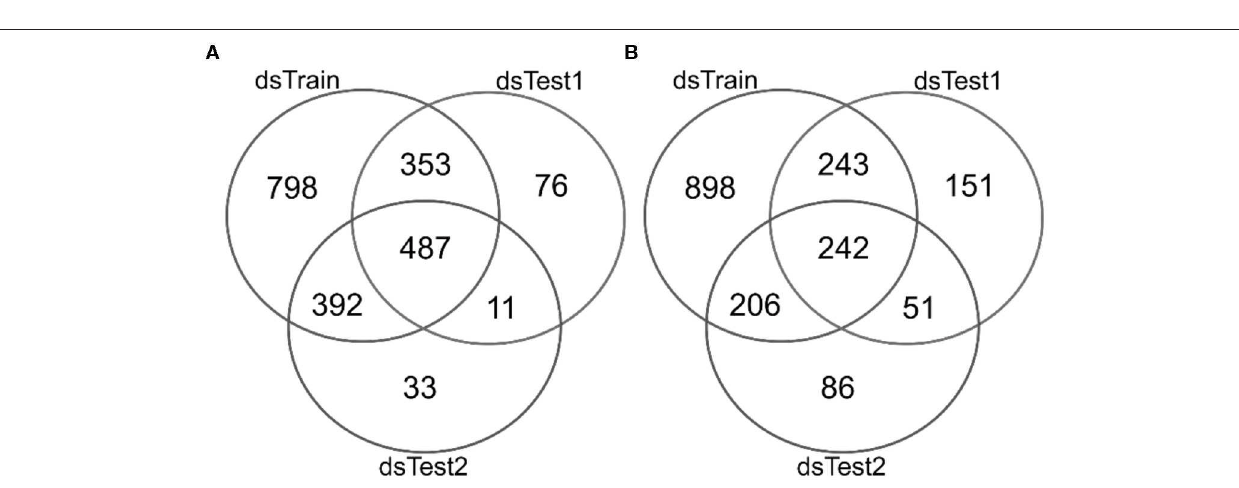
FIGURE 2 | Venn plots of the detected mqTrans features in three datasets dsTrain, dsTest1 and dsTest2. The numbers of detected mqTrans features in the three datasets (A) before and (B) after the screening criteria of mqTrans features alter in lung cancers. The Venn plot is generated using the online software from Prof.